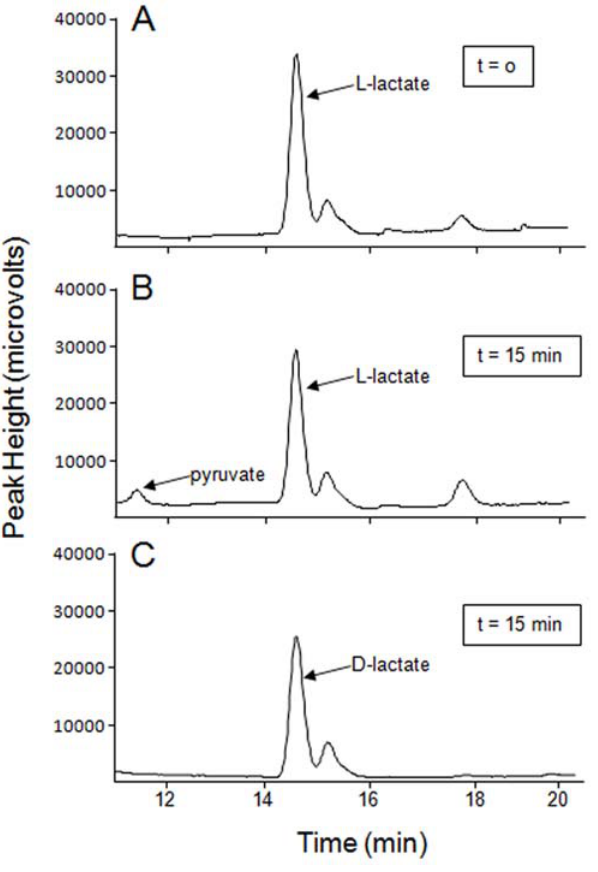
Figure 4. LctD-his 6 catalyzes oxidation of L-lactate, but not D- lactate, to pyruvate. HPLC chromatogram of LctD-his 6 in vitro enzyme reactions with (A) L-lactate as the substrate at time 0, (B) L- lactate as the substrate after 15 min, and (C) D-lactate as the substrate after 15 min. Pyruvate and D- and L-lactate were detected using a refractive index detector, and data are displayed as peak height (microvolts). Using commercially available standards, it was determined that pyruvate is detected at approximately 11.6 to 12.1 min and lactate (D and L) is detected at approximately 14.6 to 15.2 min. Representative data are shown for experiments that were performed in duplicate or triplicate.